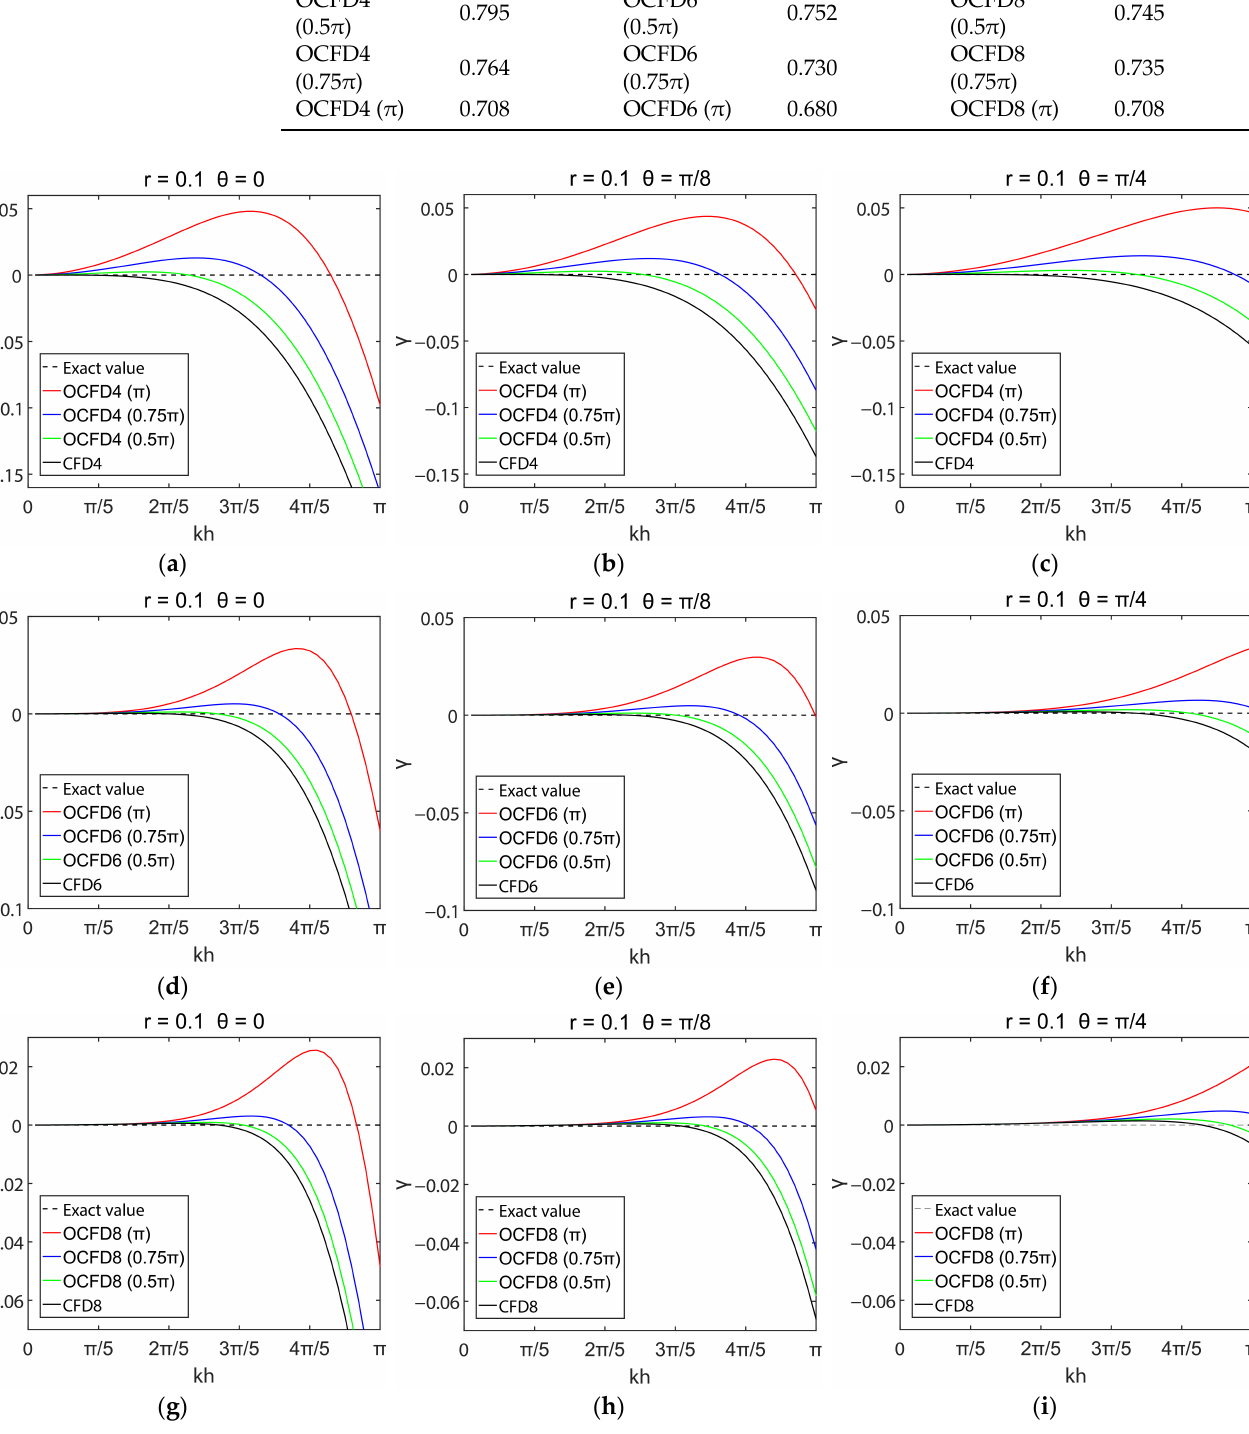
Figure 2. Dispersion curves of various θ : ( a – c ) the CFD4 scheme and its optimization schemes, ( d – f ) the CFD6 scheme and its optimization schemes, ( g – i ) the CFD8 scheme and its optimization schemes.